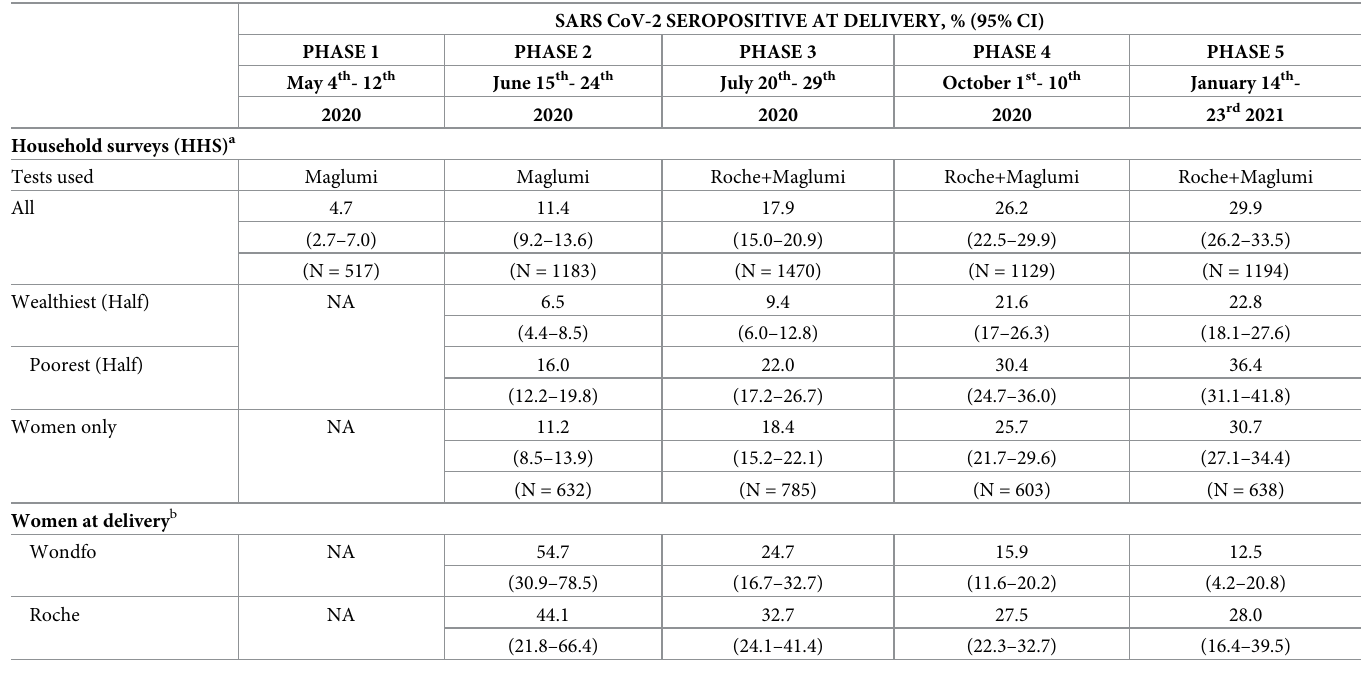
Table 3. SARS-CoV-2 seroprevalence by different assays at selected periods corresponding to phases of community household surveys